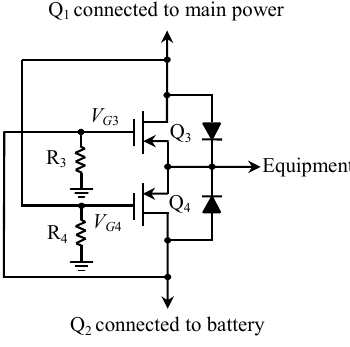
Figure 8. Mutual blocking when the main power supply is shut off. Energies 2019 , 12 , x FOR PEER REVIEW